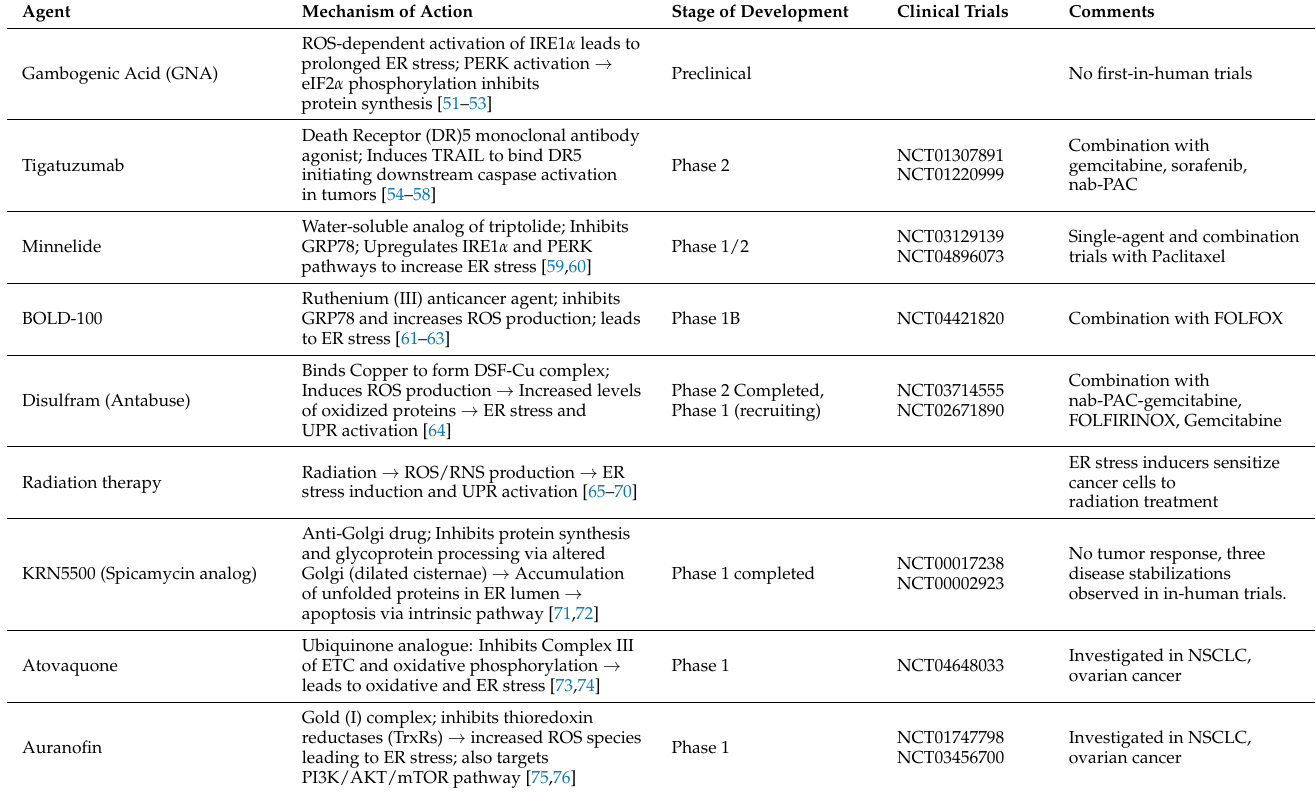
Table 2. Potential Agents to Activate UPR-Induced Apoptosis in Pancreatic Cancer.